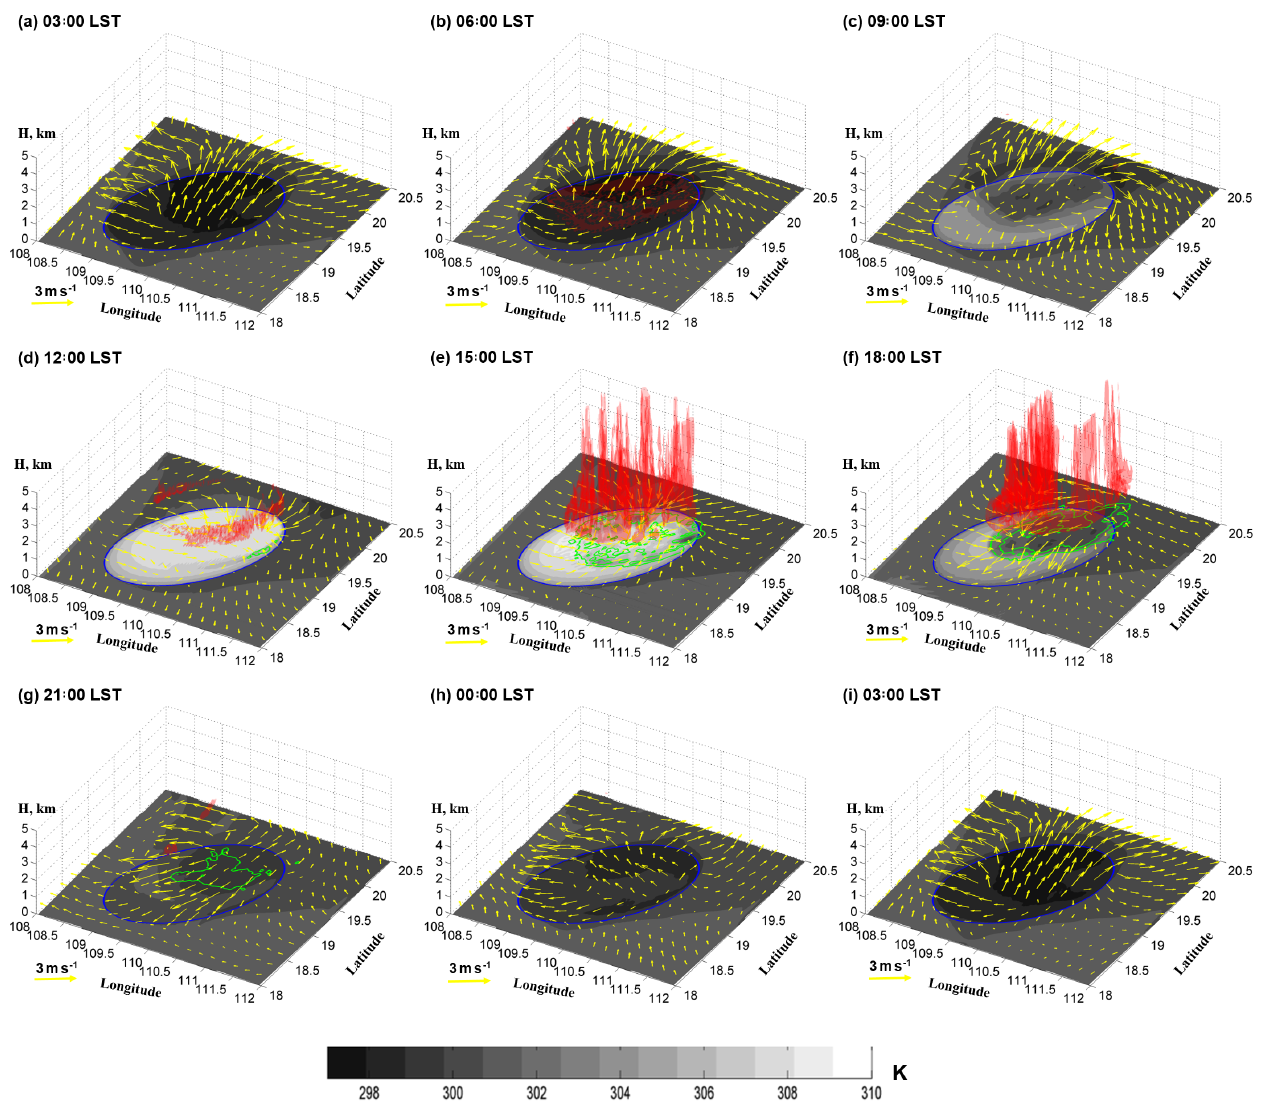
Figure 13. Cloud water mixing ratio (red shading), 2m temperature (grey shaded), perturbation horizontal wind on the second-lowest model level for horizontal wind (yellow vectors), and hourly precipitation accumulation (green contour lines) every